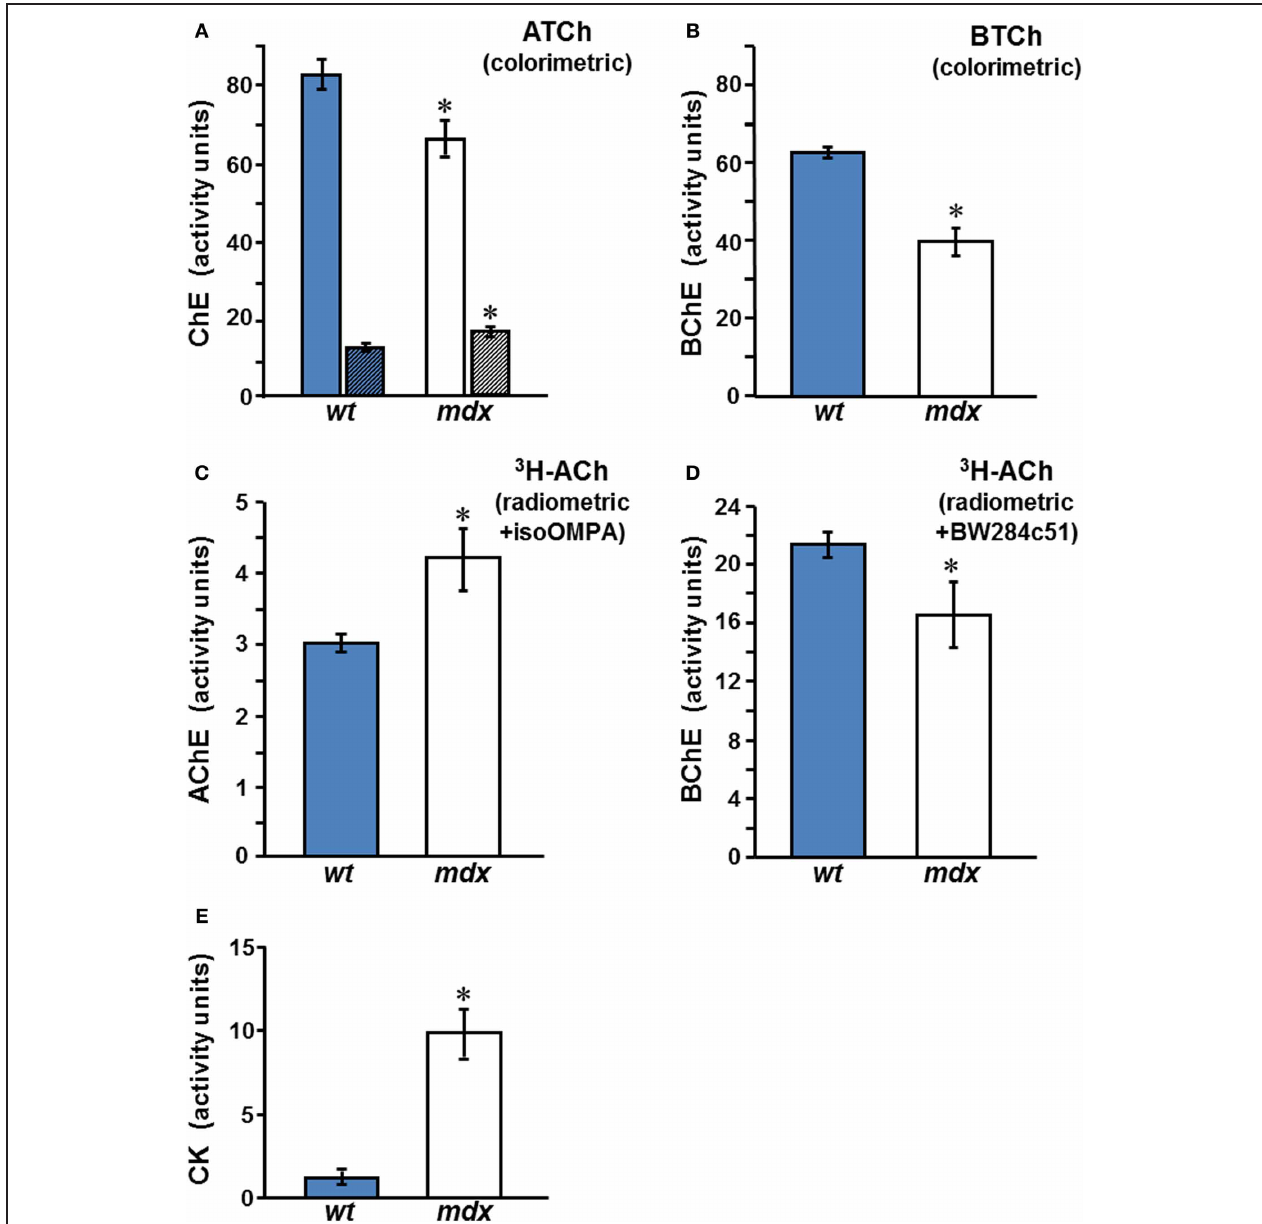
BW284c51 for BChE (D) . (E) CK levels in the sera of wt and mdx mice. Activity values represent the mean ± SEM, of samples from 6 to 8 mice per group for ChEs and of 12 animals per group for CK. Activities in mdx sera differed from wt significantly: The BChE level in mdx sera was reduced compared to wt ( ∗ p < 0 . 01 in B and < 0.05 in D ), while AChE in mdx sera was elevated compared with wt ( ∗ p < 0 . 05 in A,C ). As expected, CK levels in mdx sera were elevated, compared to those in the wt sera ( E , ∗ p < 0 . 001).